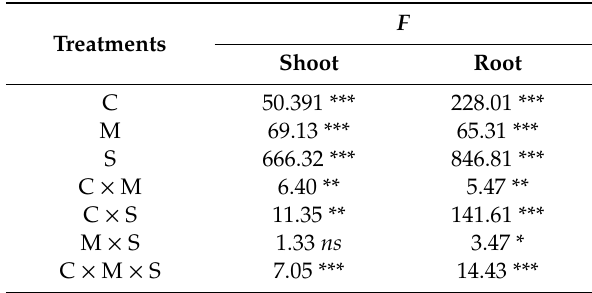
Table 4. Plant biomass production for the two wheat cultivars (C) in response to microbial treatment (M) and salt stress (S).